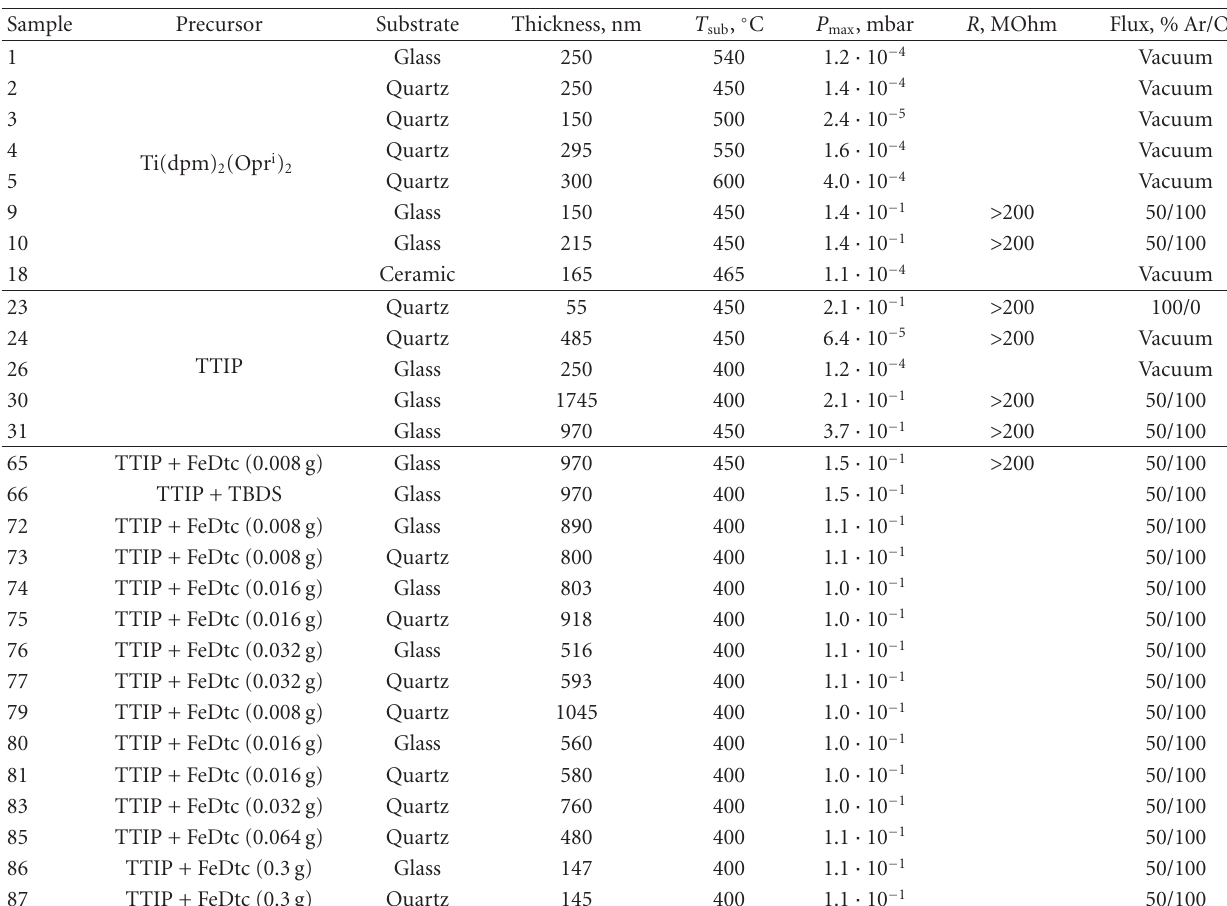
∗ 100% Flux of Ar and oxygen correspond to 20mL/min at normal